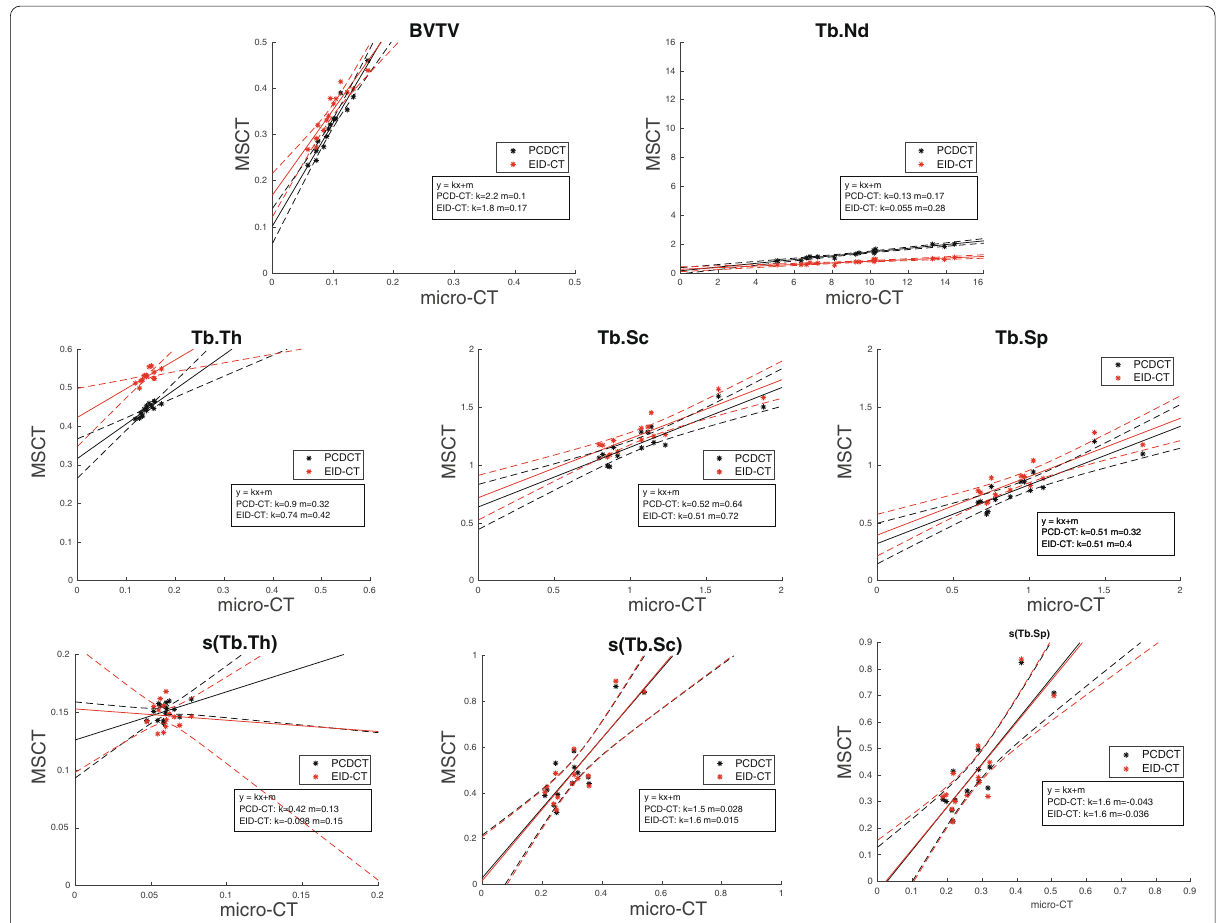
Fig. 1 Scatterplots of bone structure parameters. *For each specimen, solid line for the fitted linear model, dashed line for the 95% confidence intervals of the fitted linear model. Multislice computed tomography using energy-integrating detectors (EID-CT) is coloured red, while multislice computed tomography using photon-counting detectors (PCD-CT) is coloured black. For the PCD-CT, the combination of a field of view of 51 mm and a matrix of 1024 1024 was chosen and for the EID-CT the mAs setting with the same CTDI vol as the PCD-CT was used. BVTV Bone volume × fraction, Micro-CT Micro-computed tomography, Tb.Th Trabecular thickness, Tb.Nd Trabecular nodes, Tb.Sc Trabecular spacing, Tb.Sp Trabecular separation. Parameter for the average of each specimen and s(parameter) for the dispersion